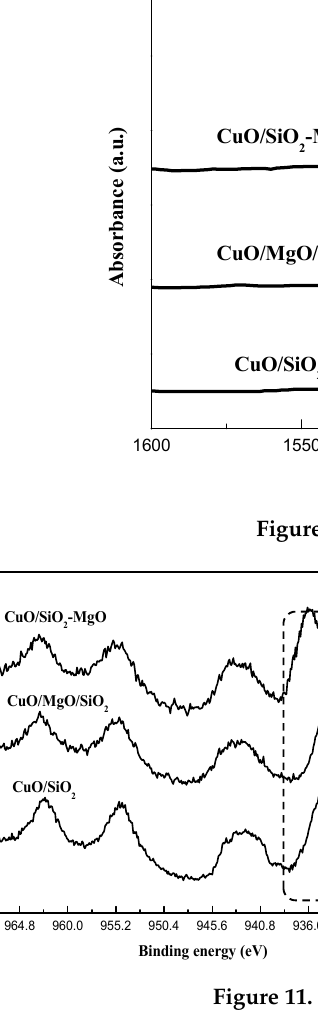
Figure 12. H 2 -TPR profiles of the catalysts. 3.3. Catalytic Performance